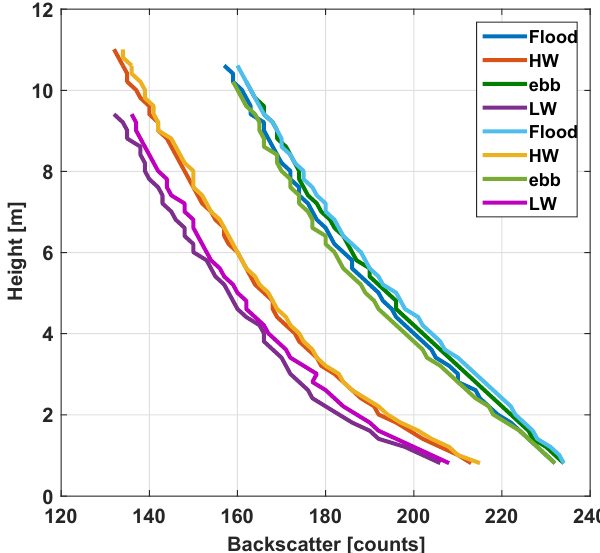
Figure 2. Example acoustic backscatter profiles measured from ADCP over height in counts observed on 29 August 2013 at dif- ferent tidal phases: flood, ebb, slack water (high water (HW), low water